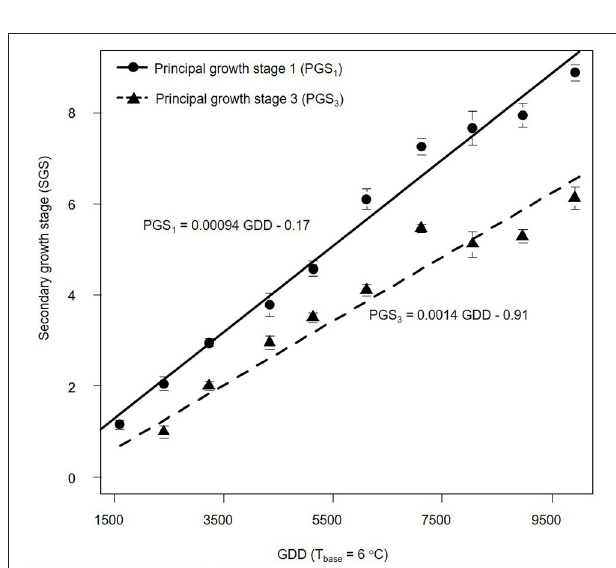
FIGURE 3 | Progression of Miscanthus × giganteus principal growth stage 1 (leaf development) and 3 (stem elongation) over growing degree days (GDD). Stages were based on the BBCH scale developmental scale. Each observation is the average of 10 stems. Vertical lines represent ± 1 standard error; see text for details on the summary statistic methods. Linear equations for each principal growth stage are provided and principal growth stage developmental rate corresponds to the slope of each equation.